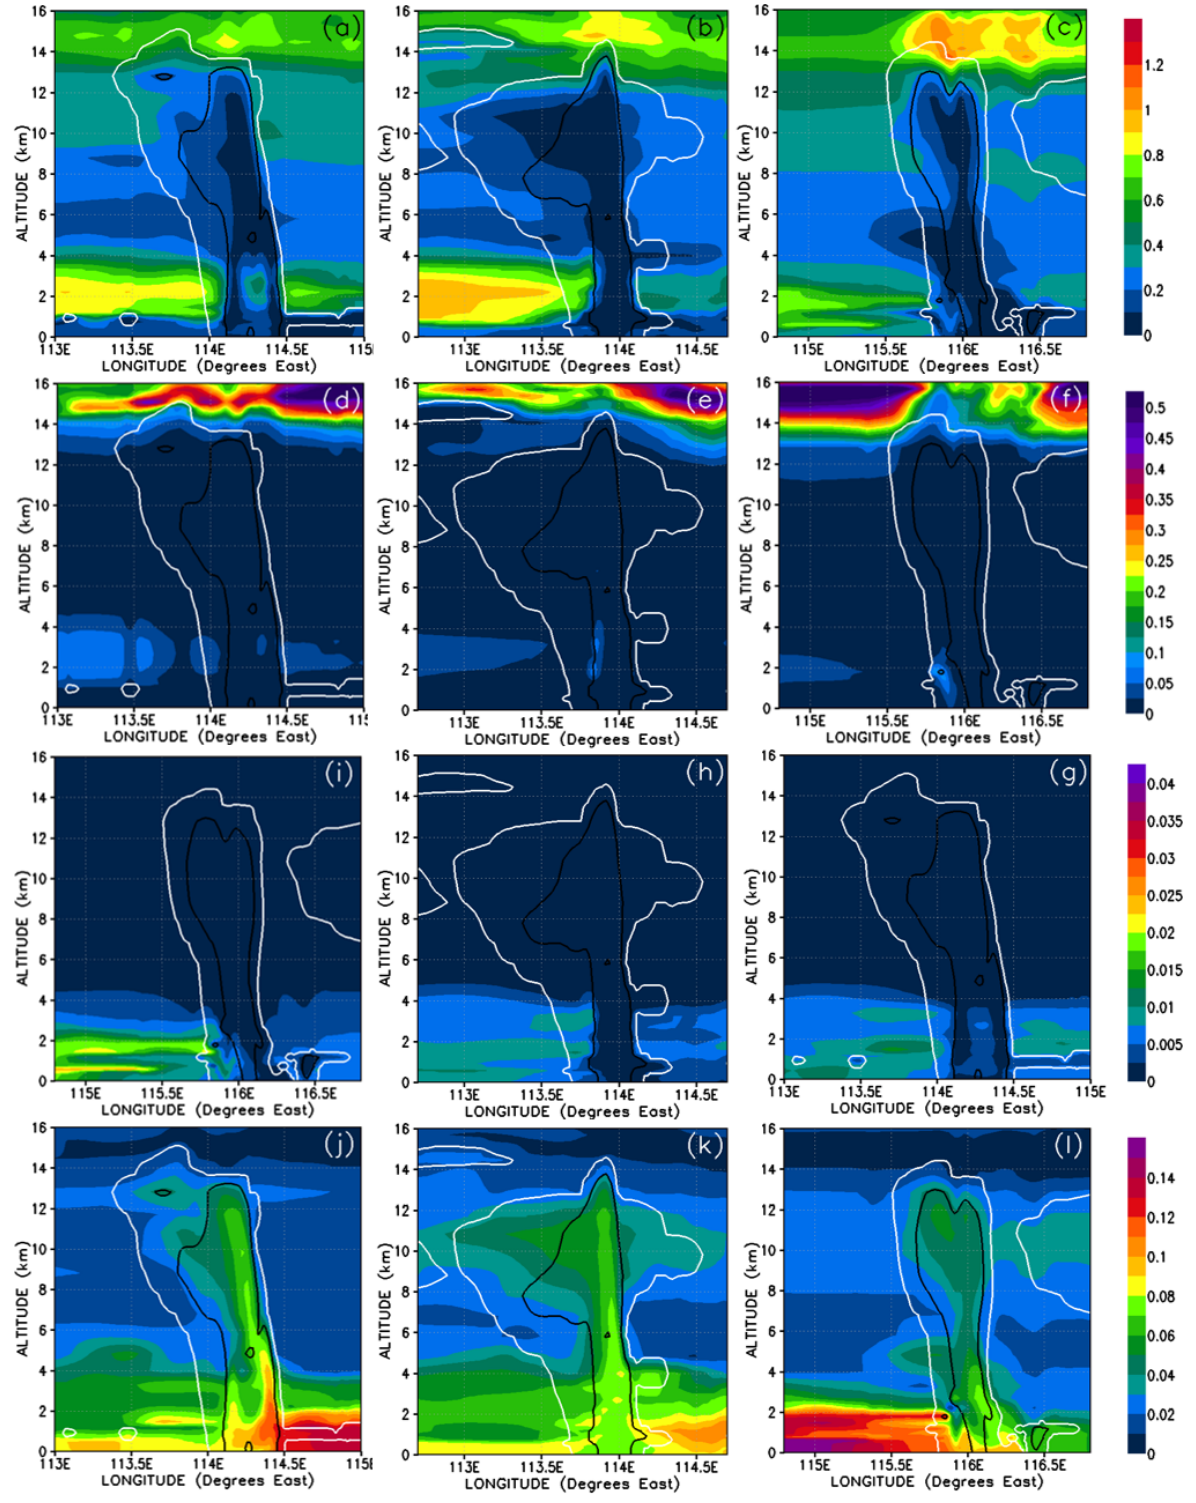
Figure 11. Vertical cross sections of mixing ratios (expressed in Br pptv) of soluble inorganic (HOBr, HBr, and BrONO 2 ) (a–c) , insol- uble inorganic (Br, Br 2 , and BrO) (d–f) , soluble organic (bromo-methyl peroxides) (g–i) , and insoluble organic (bromo-carbonyls) (j– l) bromine compounds. The left, middle, and right columns correspond to cross sections of Mod_Conv_4.35N at 4.35 ◦ N at 06:00UTC, Mod_Conv_3.75N at 3.75 ◦ N at 09:00UTC, and Mod_Conv_5.4N at 5.4 ◦ N at